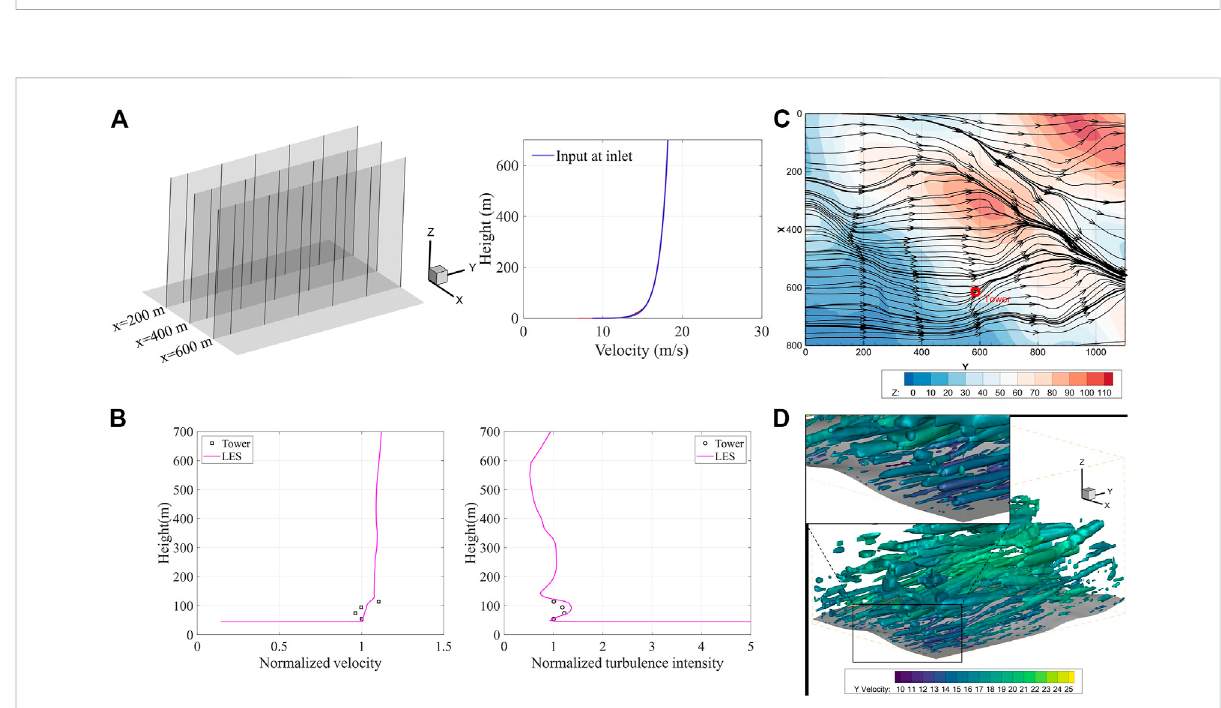
Veri fi cation of CFD simulations: (A) Equilibrium in fl ow boundary conditions: (B) Comparison of wind speed and turbulence intensity between numerical results (LES) and wind tower measurements; (C) Mean surface streamline of the wind fi eld and ground elevation (shaded, unit: m), and vertical axis (X) represents across-wind direction in meters, and horizontal axis (Y) represents fl ow direction in meters; (D) Instantaneous vortex structure of the wind fi eld colored by Y velocity (unit: